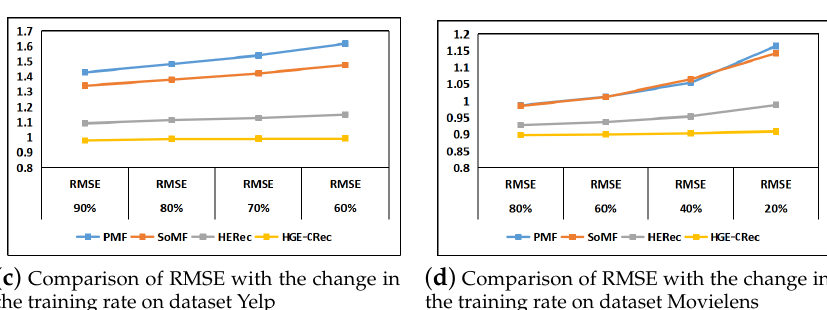
( c ) Comparison of RMSE with the change in ( d ) Comparison of RMSE with the change in the training rate on dataset Yelp the training rate on dataset Movielens Figure 6. Comparison of RMSE with the change in the training rate on four